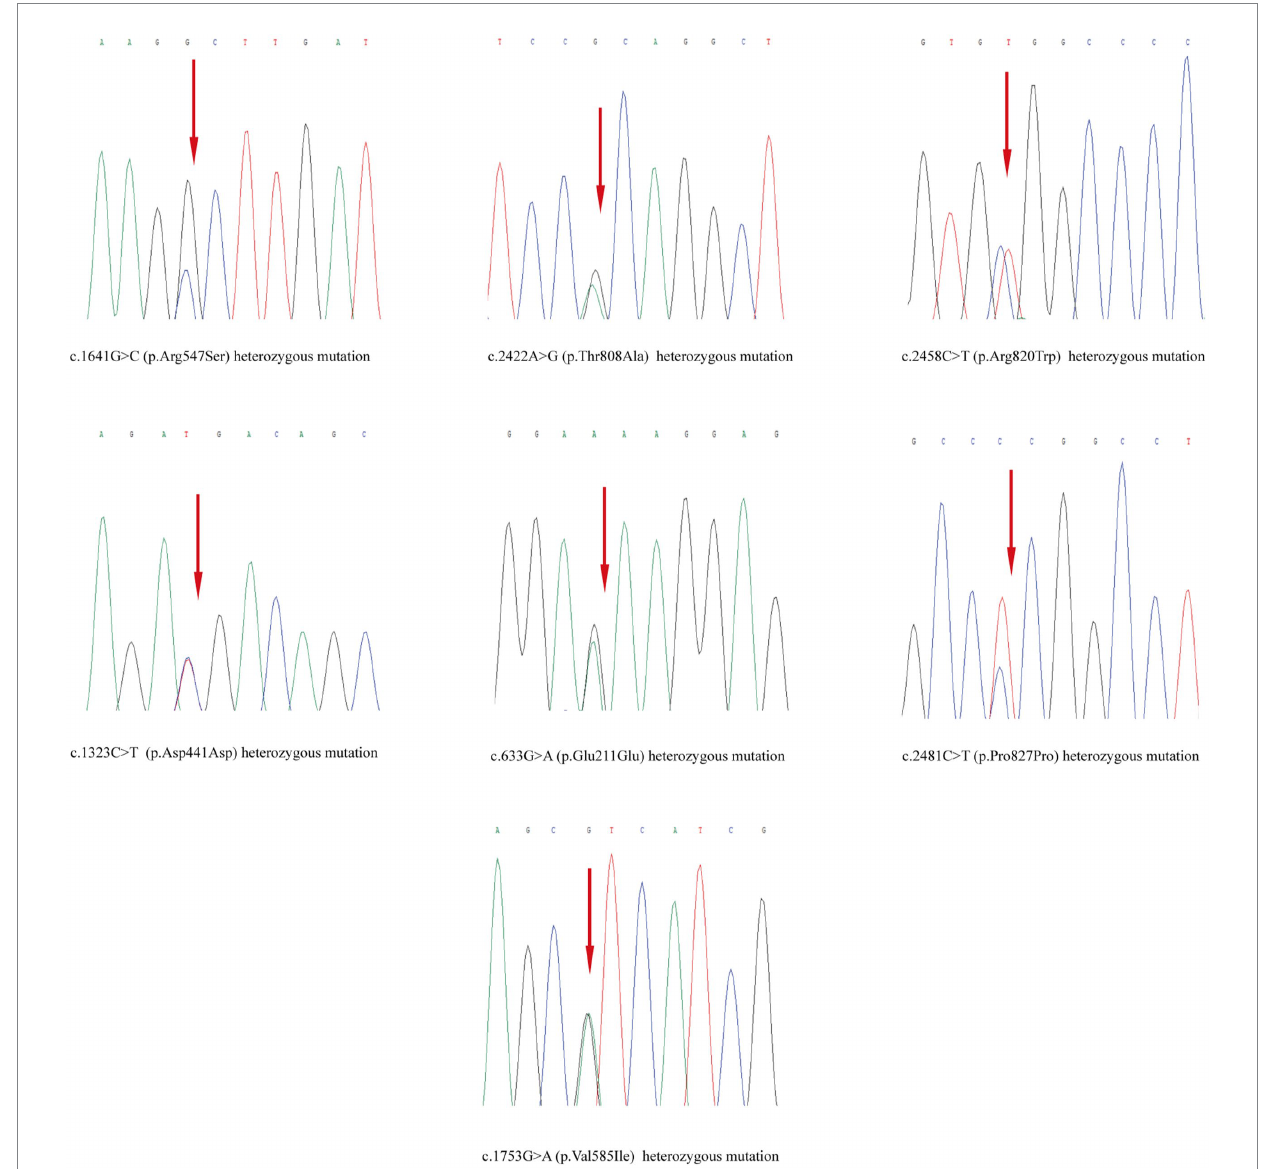
FIGURE 2 Histopathological examination of a skin biopsy from the left chest showed mild vacuolar degeneration of epidermal basal cells, varying numbers of neutrophil infiltrates in the superficial-deep dermis (mainly in the superficial dermis), and epidermal cavernous pustule formation (hematoxylin and eosin staining; original magnification,